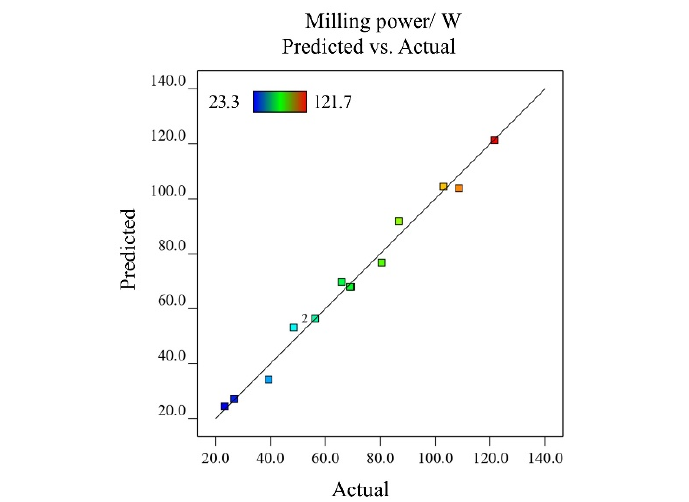
Figure 6. The plot of predicted vs. actual values for Ra, Rz, and milling power. Table 7. Results of ANOVA for the different models.